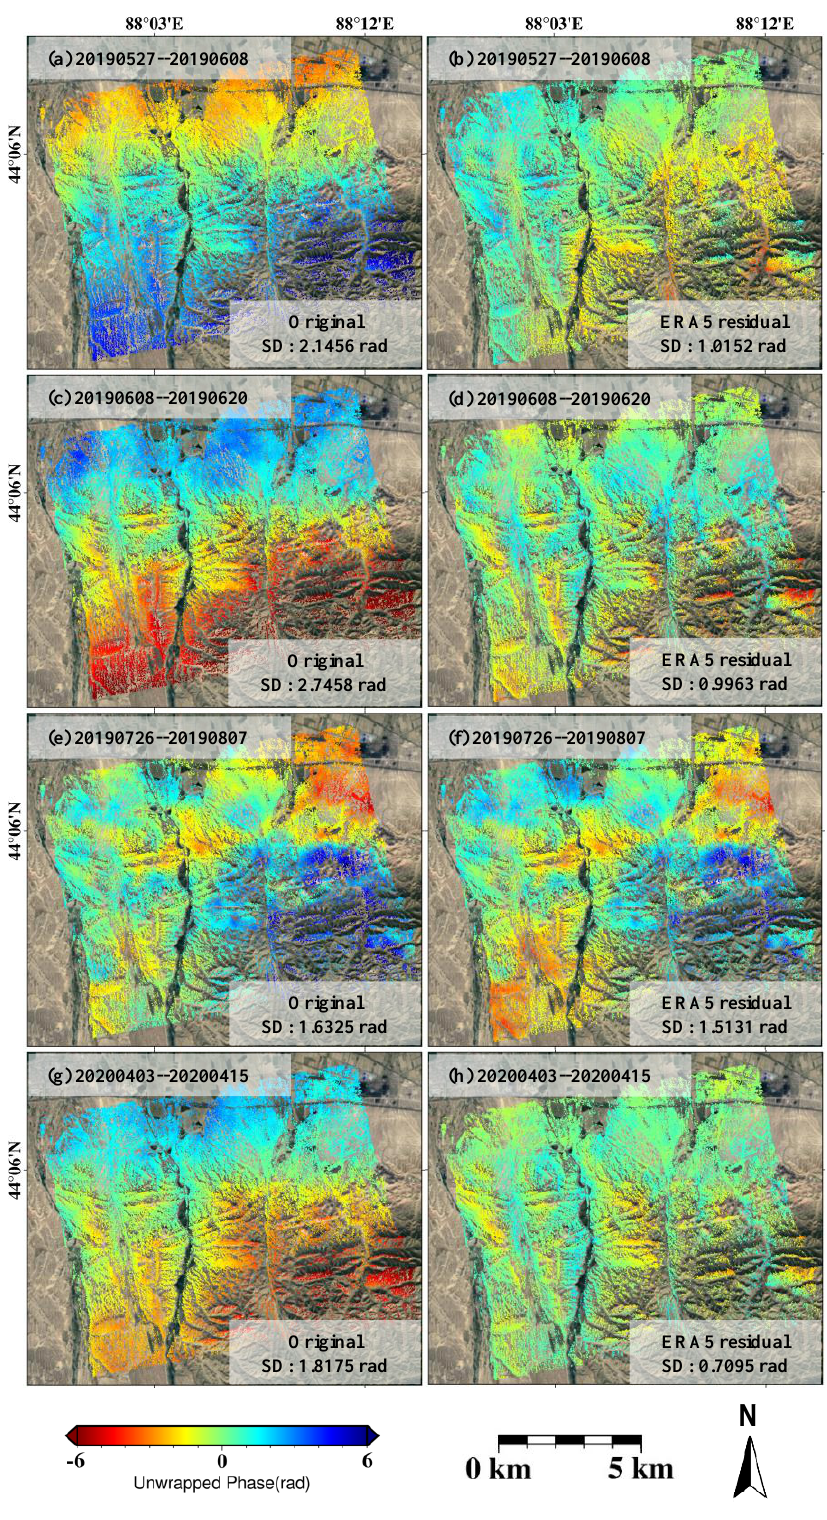
Figure 6. Phase comparison between original interferograms and ERA5 residual interferograms after TPC selection. ( a , c , e , g ) represents the original interferogram of 20190527–20190608, 20190608– gram with residual phase after atmospheric correction of corresponding time,